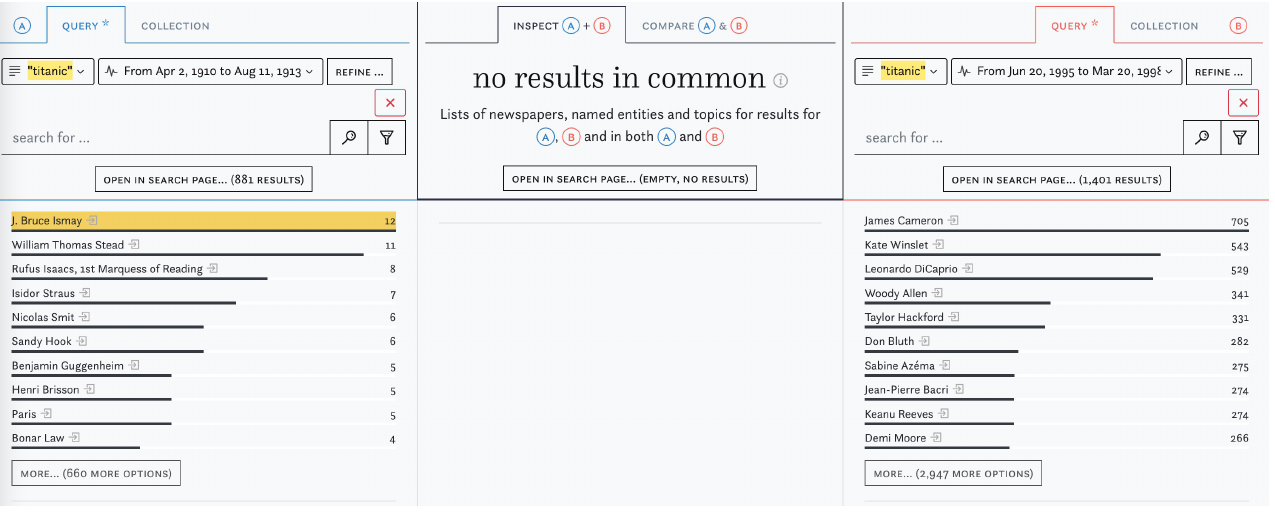
Figure 6. Comparing time periods—“titanic” around 1912 and around